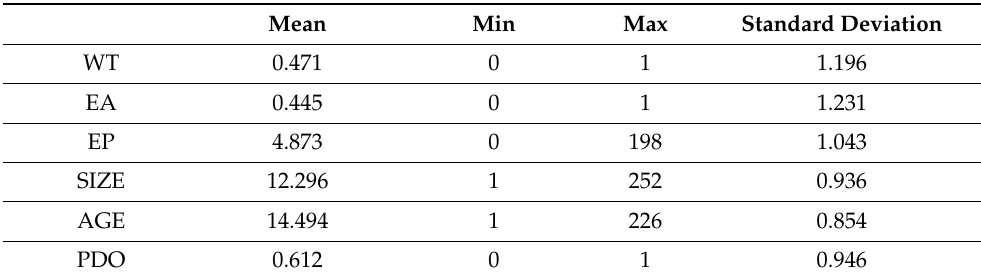
Table 2. Values of the mean, minimum value, maximum value, and standard deviation of the variables analyzed.